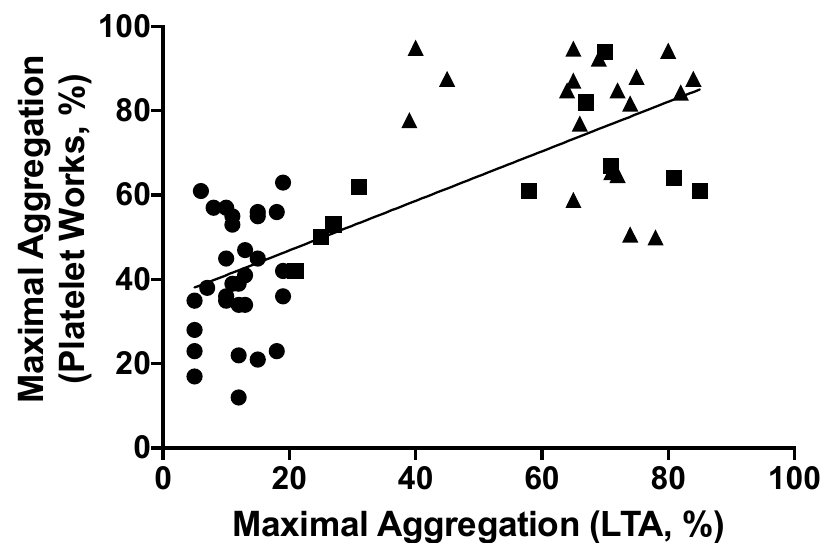
Figure 4. Pearson correlation between maximal platelet aggregation in response to Arachidonic acid using Plateletworks ® and light transmission aggregometry ( n = 60). There is a good correlation be- tween the two methods of platelet aggregation testing (r = 0.749, 95% CI: 0.6096 to 0.8432, p < 0.0001). Triangles represent patients not taking ASA ( n = 20), circles represent ASA-sensitive patients ( n = 30), and squares represent ASA non-sensitive patients ( n = 10).